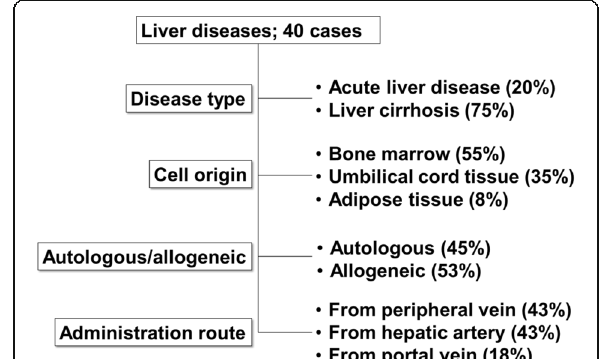
Fig. 1 Summary of clinical trials in liver